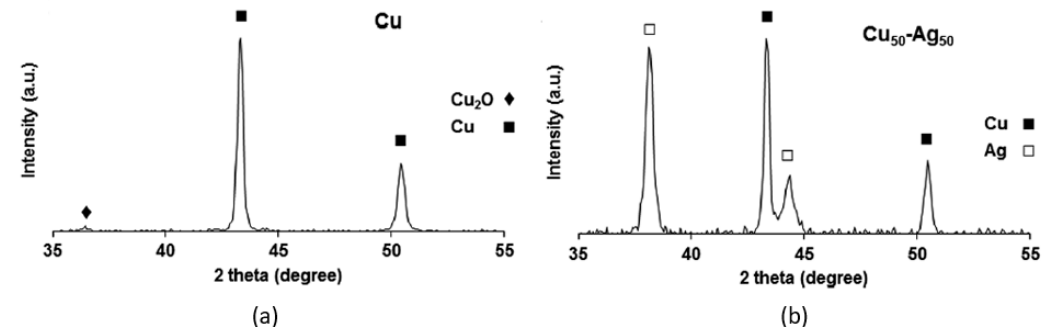
Figure 19. XRD spectra of ( a ) Cu NPs and ( b ) Cu 50 -Ag 50 NPs. Reproduced with permission from Reference [246]. Copyright 2016, Royal Society of Chemistry.